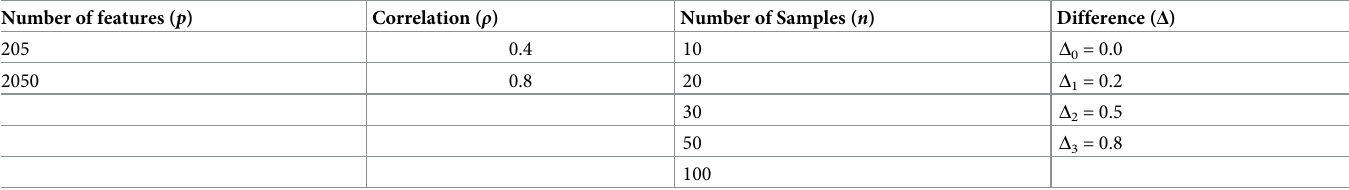
Table 1. Summary of the simulation scenarios. For each scenario 1000 datasets were simulated. All together there were 20 scenarios considered. Number of features ( p